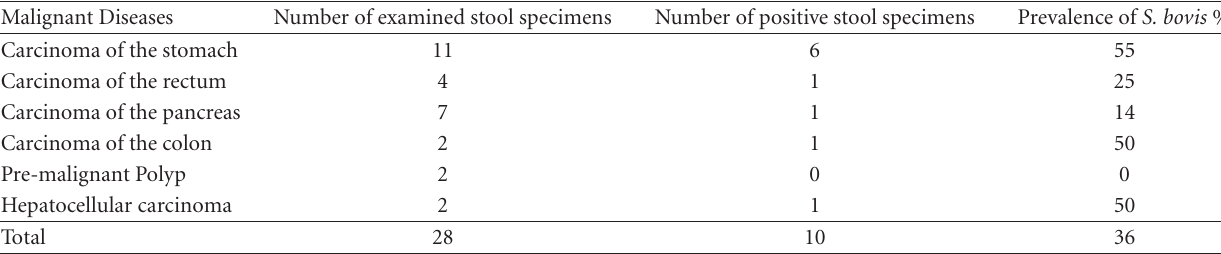
Table 3: Prevalence of S. bovis isolated from patients with malignant gastrointestinal diseases.